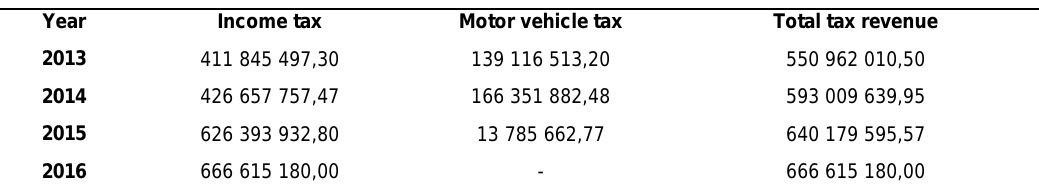
Table 2. Development of the tax share for regional self-government in the Slovak Republic from 2013 to 2016 (in